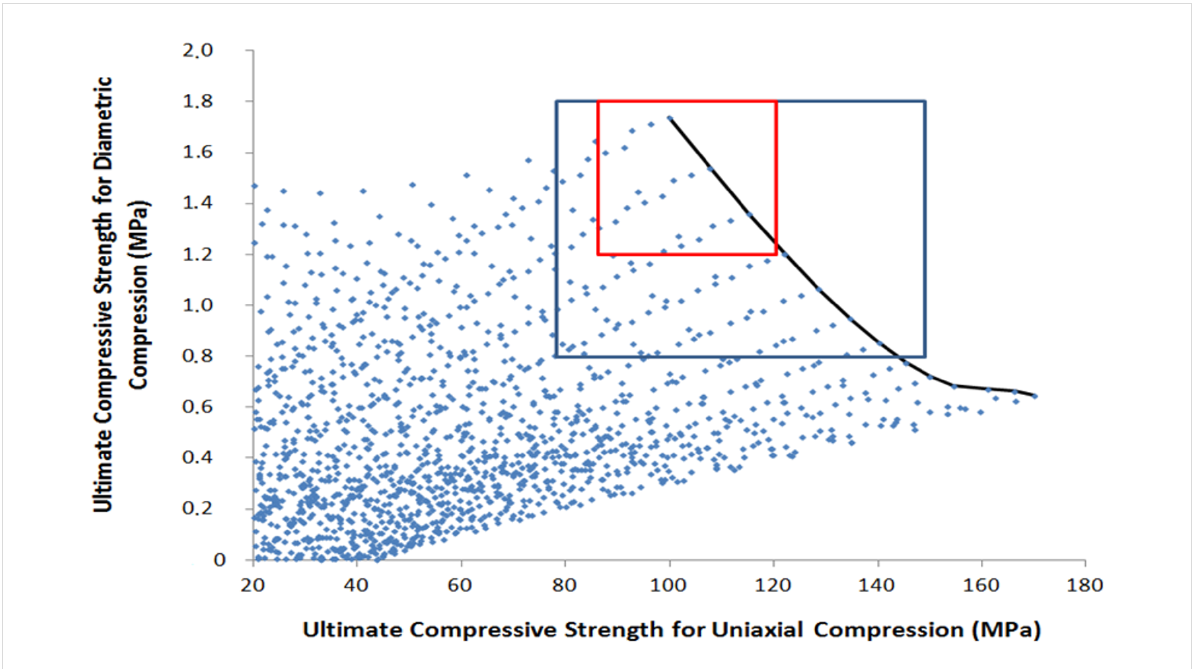
Figure 8: Operating points in a Y (MPa) vs Z (MPa) diagram. Y ( Z ) is the ultimate compressive strength for diametric (uniaxial) compression. The black curve is called the Pareto curve. The red square is the selection of the best pellets; Y ≥ 90 MPa and Z ≥ 1.2 MPa. The blue square represents a larger selection of the optimum pellets; Y ≥ 80 MPa and Z ≥ 0.8 MPa.